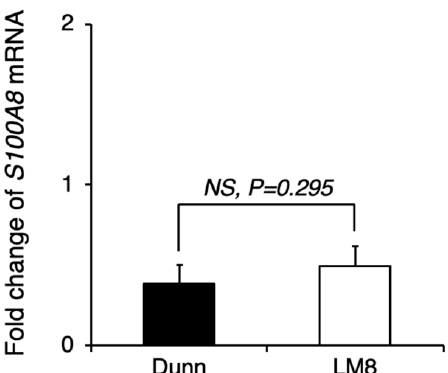
Figure A3. Comparison of pre-metastatic niche preparation between LM8 and Dunn. LM8 or Dunn cells were transplanted into the right hind leg, and 17 days later, the lung tissue sample was collected for qRT-PCR. S100A8 mRNA expression in the lung tissue of LM8 and Dunn was evaluated by qRT-PCR. NS, no significant di ff erences, by Student’s t -test. Bars indicate standard error calculated using data from three independent trials.